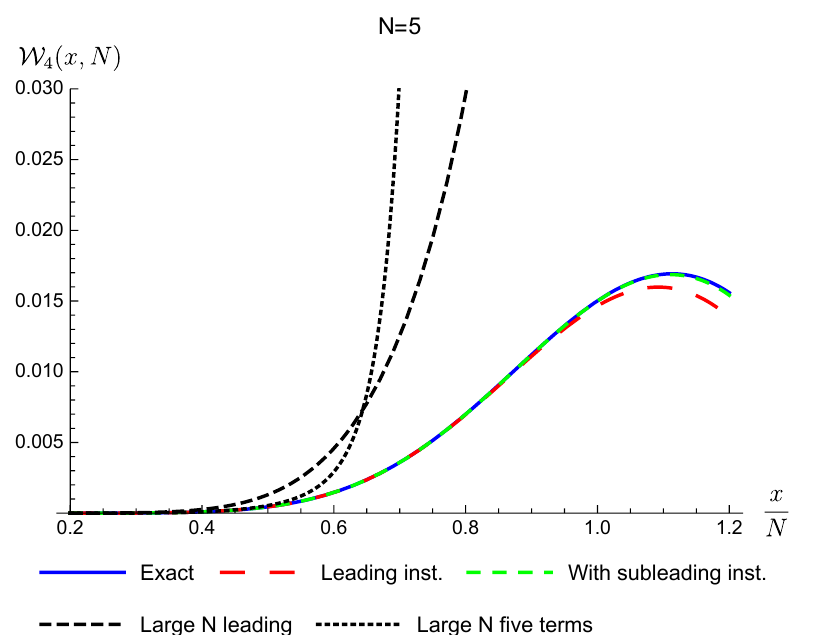
Figure 19 . The solid blue curve shows the exact numerically calculated Wilson loop W 4 as a function of the inverse ’t Hooft coupling 1 =t (cid:17) x=N , compared to W 4 calculated from the strong coupling expansion for (cid:1) (5.10). The large dashed red curve (with (cid:1) (cid:25) (cid:1) ) and medium dashed (1) green curve (with (cid:1) (cid:25) (cid:1) +(cid:1) ), show the leading and also subleading strong coupling instanton (1) (3) contributions. These agree well with the exact result all the way to the transition point at x = N . The black curves with medium and small dashes show W 4 calculated from the one-instanton series in the large N strong coupling expansion (5.38), with just the leading term and the (cid:12)rst (cid:12)ve terms (see equation (4.8) in [53]), respectively. All quantities are calculated at N =